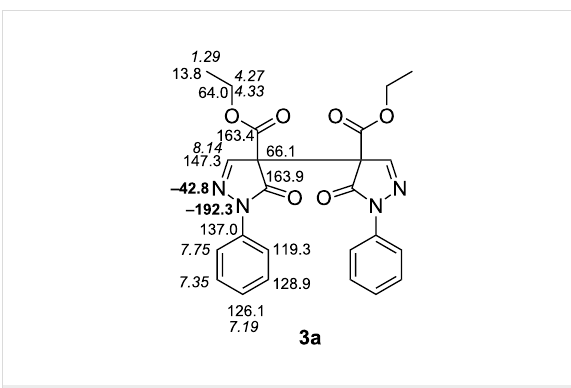
Figure 4: 1 H NMR (italics), 13 C NMR (normal letters) and 15 N NMR (in bold) chemical shifts of 3a (in CDCl 3